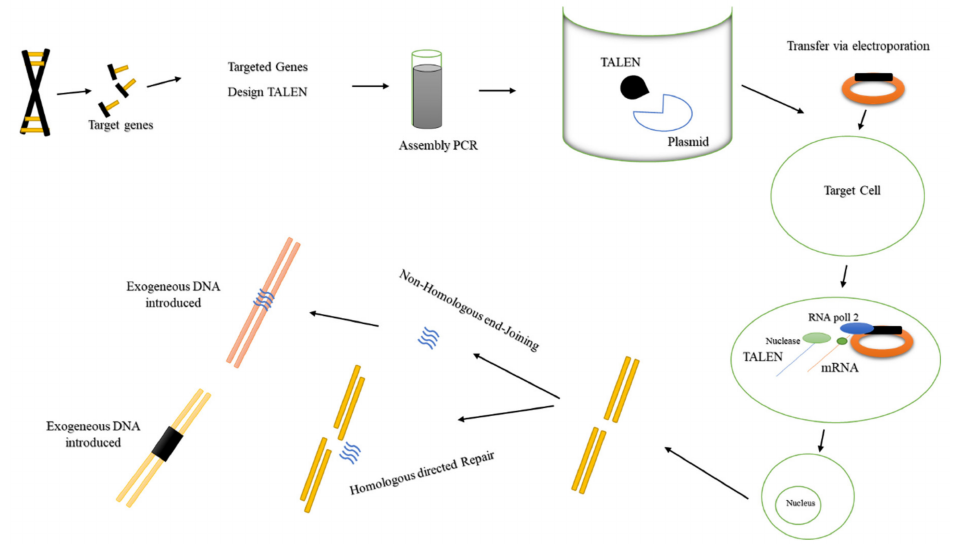
Figure 3. Transcription activator-like e ff ector nucleases (TALENs) are dimeric transcription factors / nucleases engineered from an array of 34-amino-acid molecules, each of which targets one nucleotide. The target sequence is recognized; a corresponding TALEN sequence is built and inserted into a cellular plasmid. The cellular plasmid is inserted into the host cell, where it is translated to produce the functional TALEN, which penetrates the nucleus and binds to and cleaves the target sequence. The applications of this system include the knockout of a target gene or the addition of a replacement nucleotide into the target